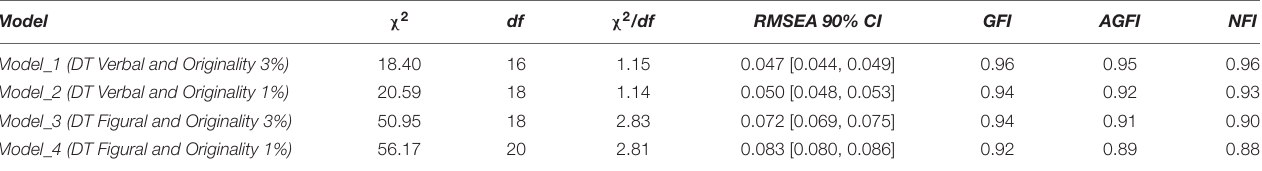
TABLE 5 | Goodness-of-fit indices for the different